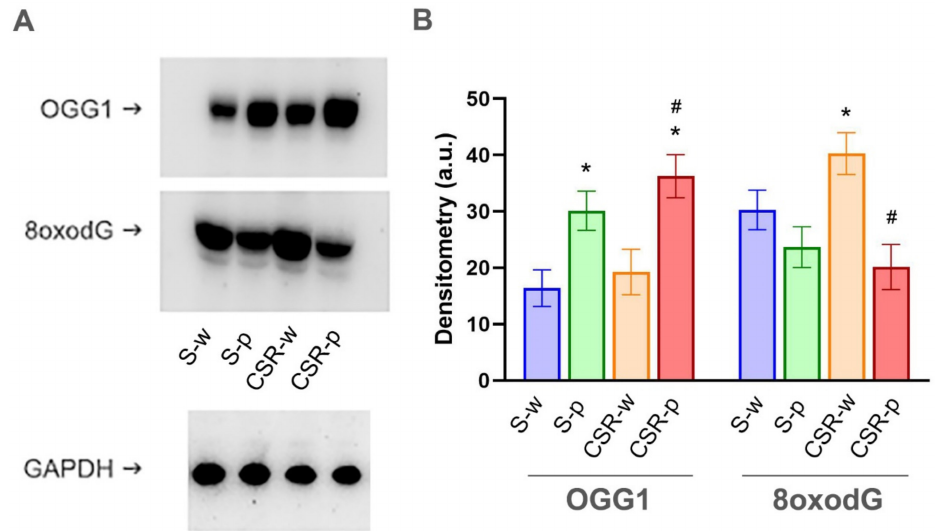
Figure 3. Effects of CSR and SLAB51 on DNA oxidation. ( A ). Representative bands for OGG1 and 8-oxodG levels in brain homogenates of all groups. Equal protein loading was verified by using an anti-GAPDH antibody. ( B ). Quantification of OGG1 and 8-oxodG levels. The densitometric analyses obtained from three separate blots. Values are mean ± SEM. One-way ANOVA results were (F (3, 24) = 6.304; p = 0.00262) for OGG1, (F (3, 24) = 6.698; p = 0.00192) for 8oxodG. * indicates statistical significance relative to S-w, while # indicates statistical significance between CSR-w and CSR-p.